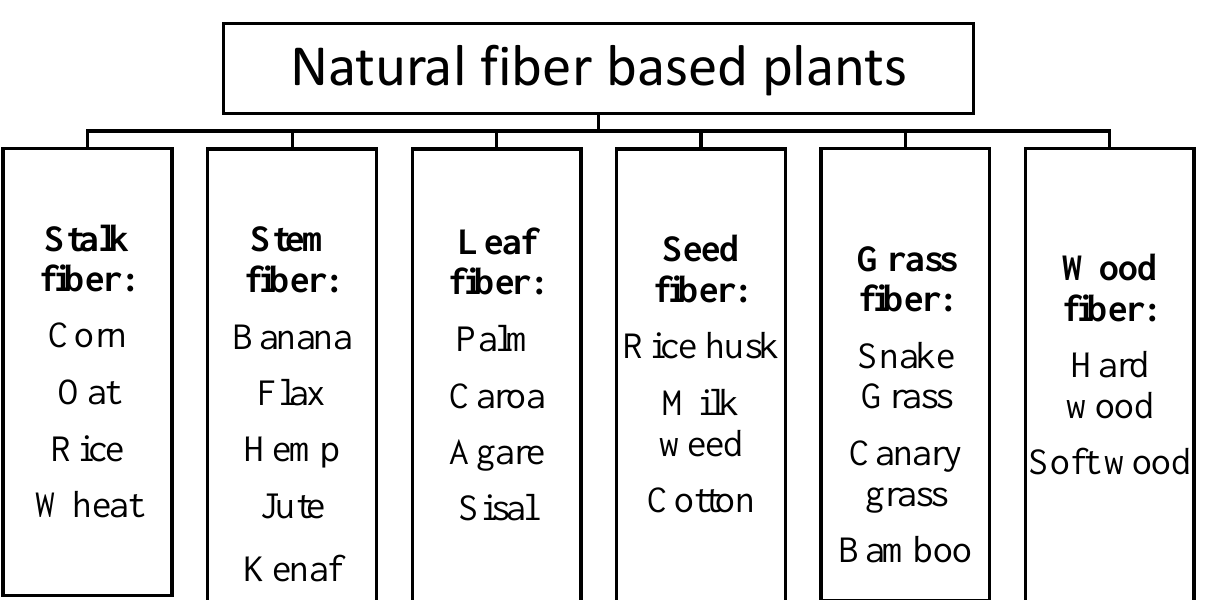
Figure 1. Classification of natural fiber